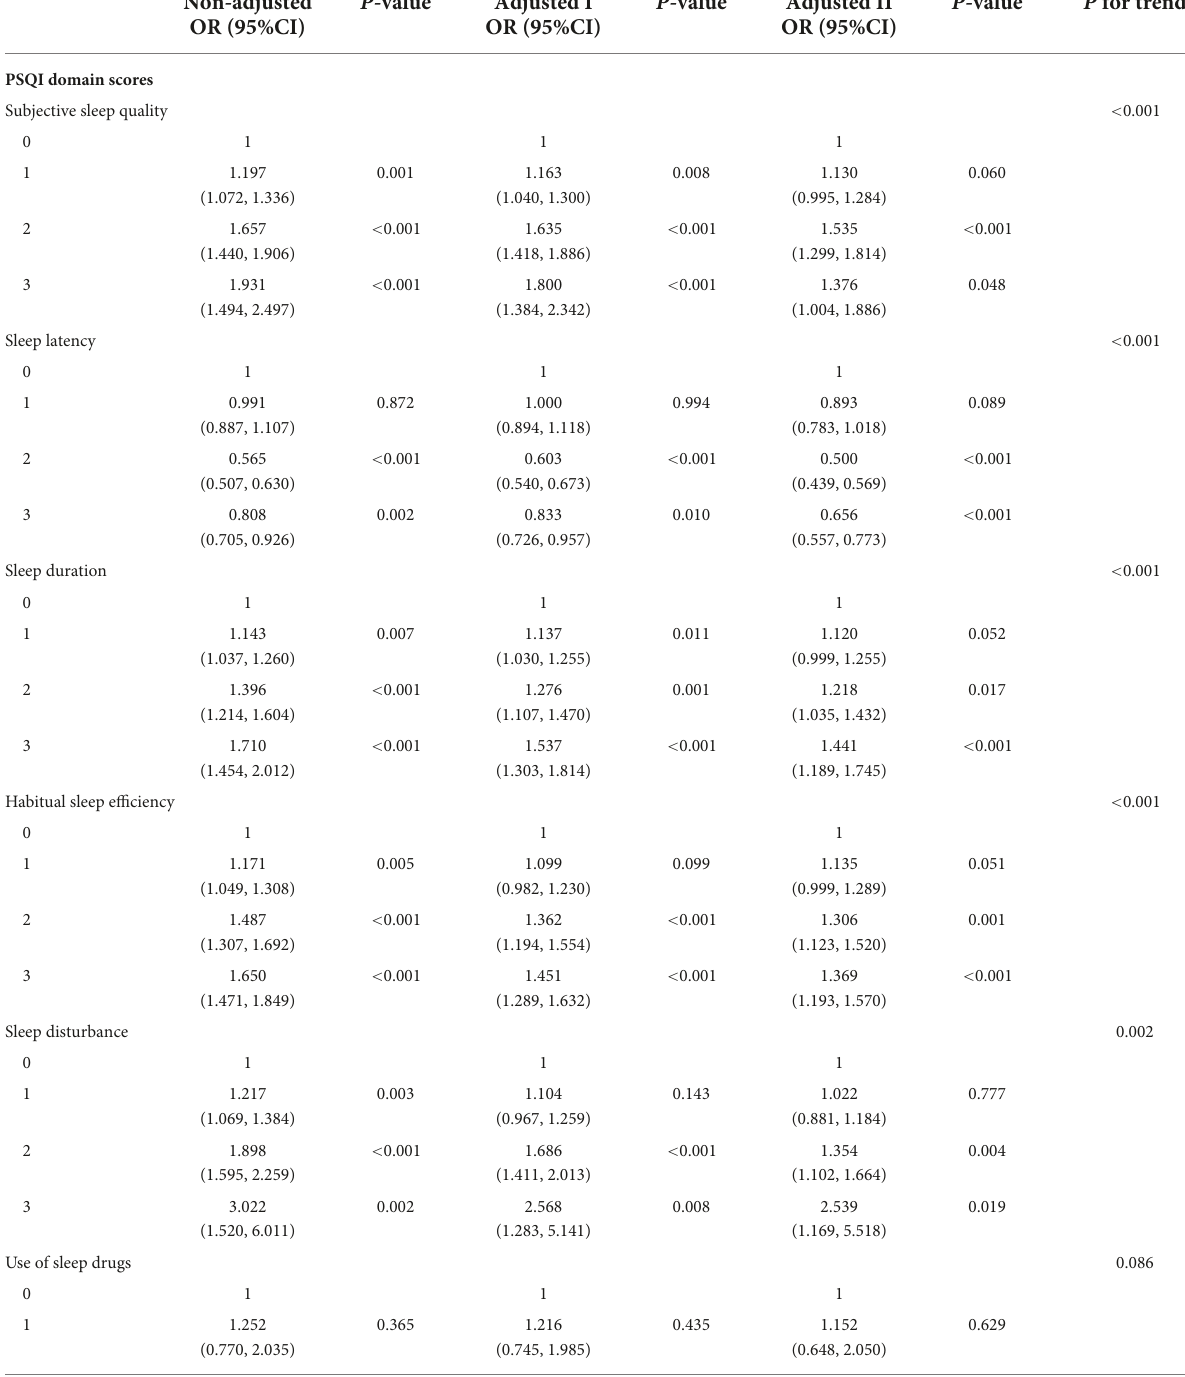
TABLE 3 Regression analysis between PSQI components and LUTS/BPH regression